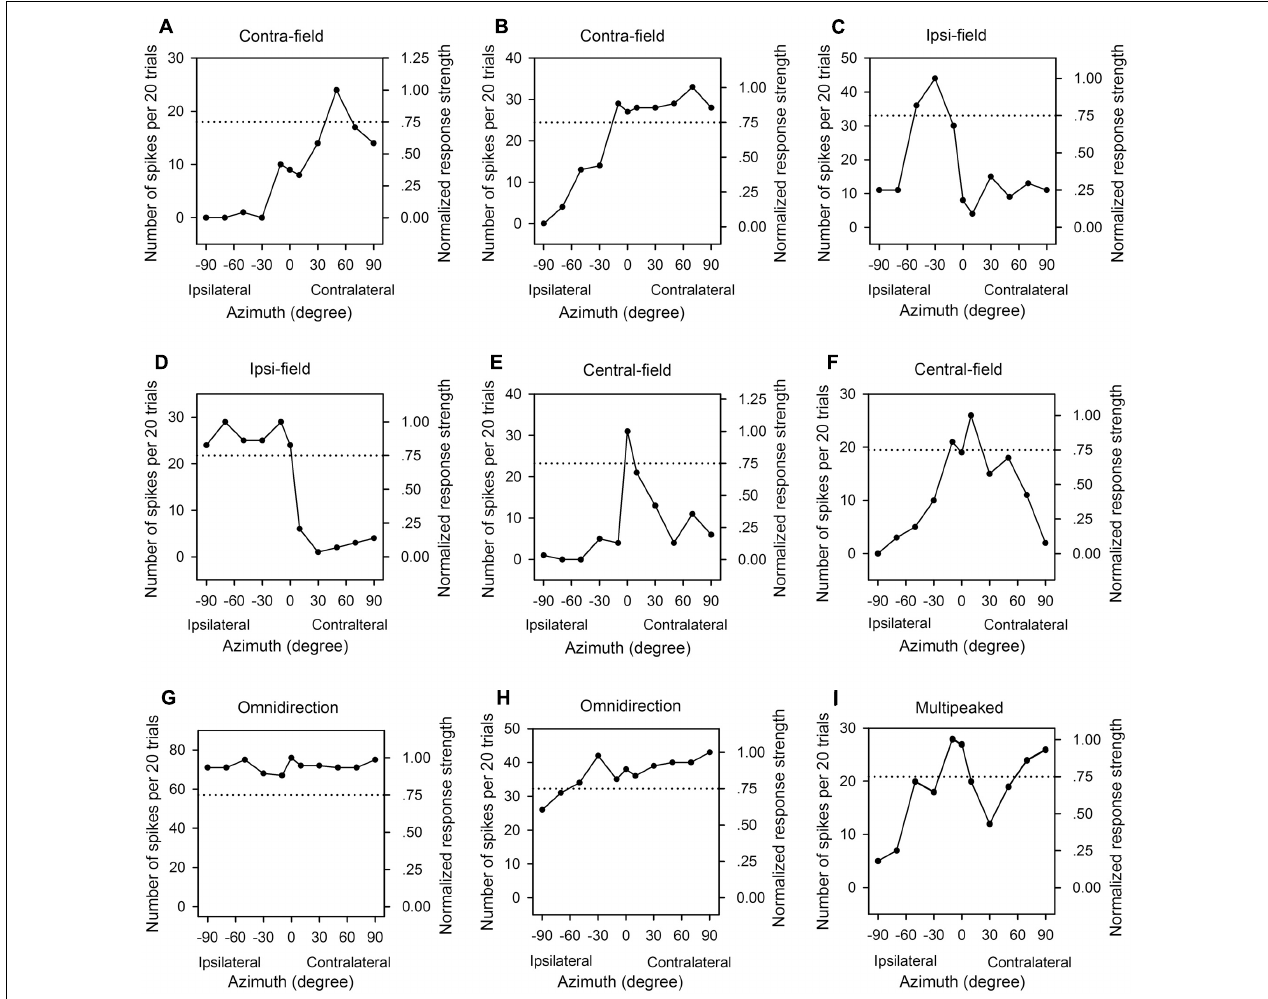
FIGURE 3 | The azimuth functions of nine representative AI neuron with various azimuth preferences. Each panel shows the data from one neuron, the left y -axis indicates the number of spikes per 20 trials, and the right y -axis indicates the normalized response strength. The x -axis indicates the loudspeaker locations in azimuth (degree). The dotted line in each panel indicate 0.75 in normalized response strength. (A,B) Contralateral azimuth preference (Contra-field). (C,D) Ipsilateral azimuth preference (Ipsi-field). (E,F) Central azimuth preference (Central-field). (G,H) Omnidirection. (I) Multipeak. The frequencies (kHz) and the levels (dB SPL) of sounds used to determine the azimuth functions are as follows: (A) 8.0 kHz, 45 dB SPL; (B) 9.0 kHz, 60 dB SPL; (C) 11.0 kHz, 45 dB SPL; (D) 34.0 kHz, 35 dB SPL; (E) 14.0 kHz, 30 dB SPL; (F) 10.1 kHz, 40 dB SPL,